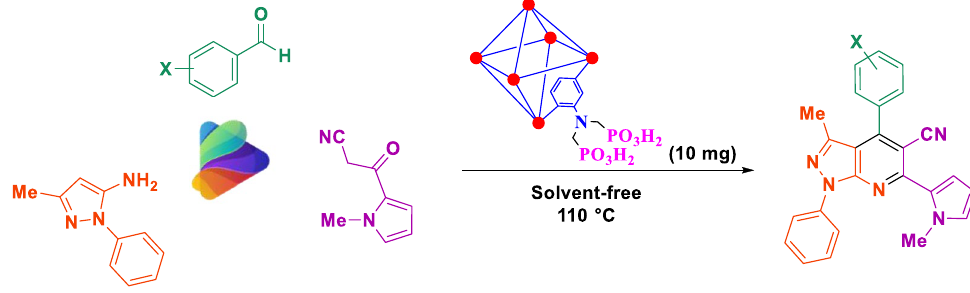
Figure 3. Synthesis of new ( N -methyl-pyrrol)-pyrazolo[3,4- b ]pyridines using MIL-53(Al)-N(CH 2 PO 3 H 2 ) 2